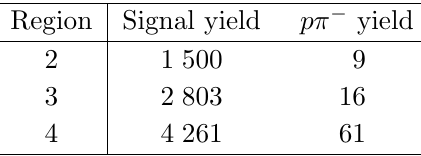
Table 2 . Estimated contributions from the p(cid:25) (cid:0) nonresonant components in di(cid:11)erent phase space regions. The signal yields from table 1 are also included for